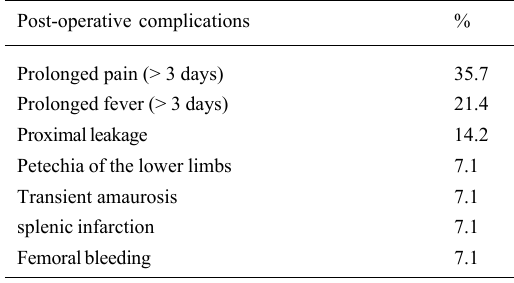
Table 3. Post-operative complications Post-operative